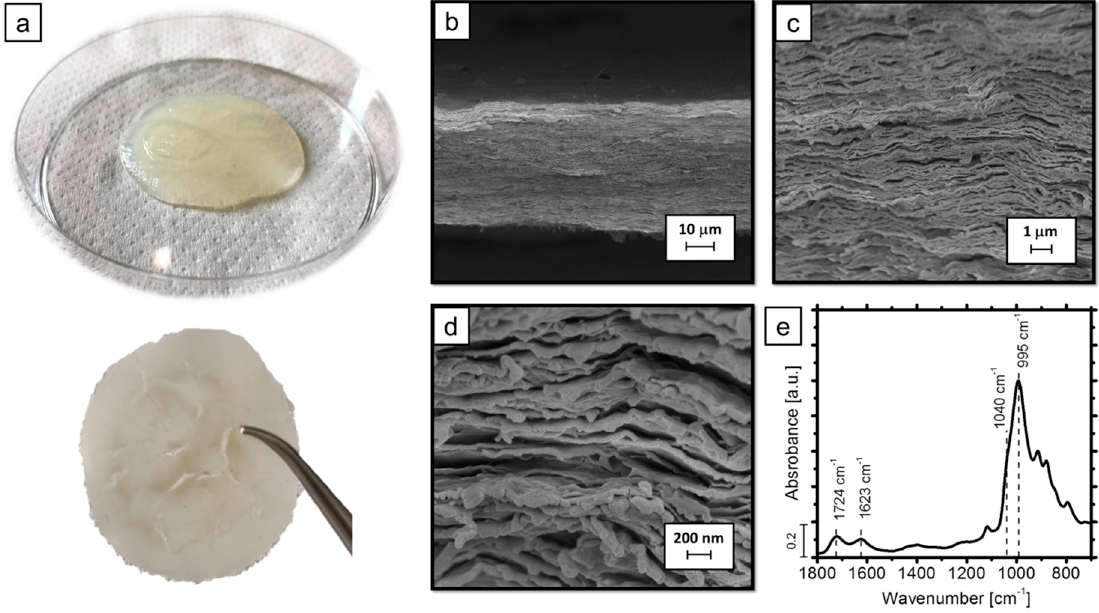
Figure 2. Digital images of the complexes before and after drying ( a ); field emission scanning electron microscopy (FESEM) observations of the film cross section at different magnifications ( b – d ) and attenuated total reflectance (ATR) spectrum of the film ( e ).